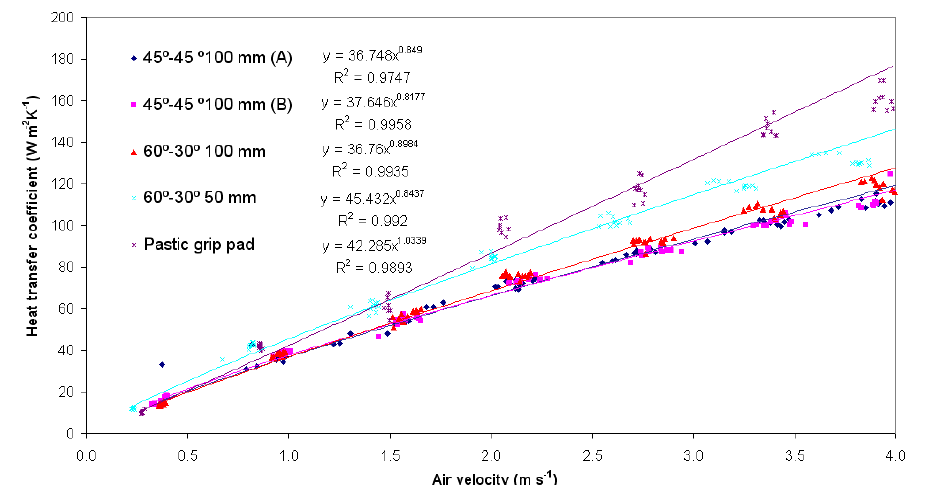
Figure 8. Comparison of the heat transfer coefficients of the cellulose pads and the plastic grid block at different air velocities and water